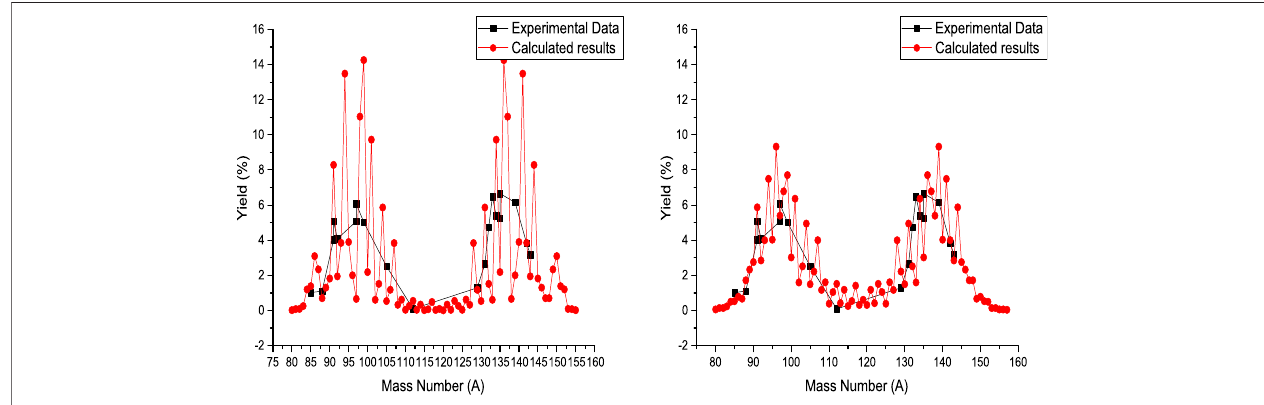
FIGURE 7 | Calculated mass yield for photo fi ssion of 237 Np at 9.5 MeV bremsstrahlung endpoint energy, accompanied by experimental data [43]. In the left and right sides are presented the calculated results obtained for T coll (cid:1) 1 MeV and T coll (cid:1) 2 MeV,